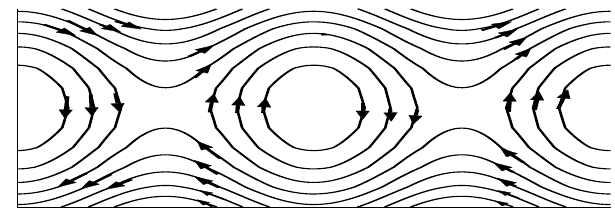
Fig. 1. Contour plot of the stream function associated with Kelvin- Helmholtz billows. The vertical and horizontal distances respec- tively represent the extent of the vertical ( ∼ 6km) and horizontal ( ∼ 16km) displacements inside the